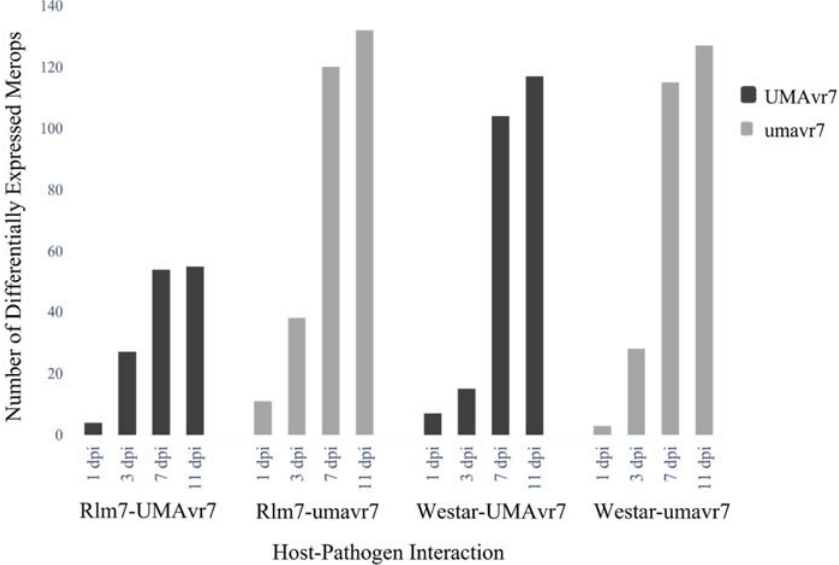
Figure 9. Differentially expressed Merops of Leptosphaeria maculans UMAvr7 and umavr7 isolates in infected host plants. Dual RNA-seq results exhibited differentially expressed Merops (peptidases) of UMAvr7 and umavr7 isolates in both infected 01-23-2-1 (Rlm7 line) and Westar plants. The differential expression of peptidases was higher in compatible interactions than in the incompatible interaction. The expression level was increased with time from 1- to 11-dpi in each interaction. Results were representative of three biological replicates. The results were considered at the fold-change cutoff (logFC) of ≥ 1 and ≤ − 1 and false discovery rate (FDR) of ≤ 0.05.